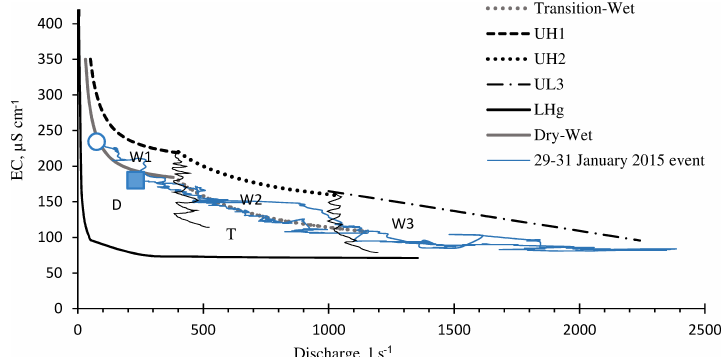
Figure 8. Delimitation of the five inner fields that define the limits of seasonal response of the catchment (modified from Cuomo and Guida, 2016) and, in blue, the hysteretic cycle of the study event, from its beginning (blue circle) to its end (blue square). Legend: UH1 and W1, upper hyperbolic curve 1 and wet area 1, respectively (typical of the Q -EC mixed value of groundwater and groundwater ridging); UH2 and W2, upper hyperbolic curve 2 and wet area 2, respectively (typical of the Q -EC mixed value of groundwater, groundwater ridging and subsurface flow); UL3 and W3, upper linear curve and wet area 3, respectively, typical of the Q -EC mixed value of groundwater, groundwater ridging subsurface flow and direct runoff; LHg, lower hyperbolic curve typical of the Q -EC response when direct runoff is suddenly added to the groundwater following the heavy showers that occurred during the dry period; D , the dry area where the Q -EC typical of a dry fall for which only the groundwater flow feeds the streamflow; T , transition area, where the Q -EC typical values of a dry–wet or wet–dry fall, when the groundwater flows, groundwater ridging and soil pipe feed the